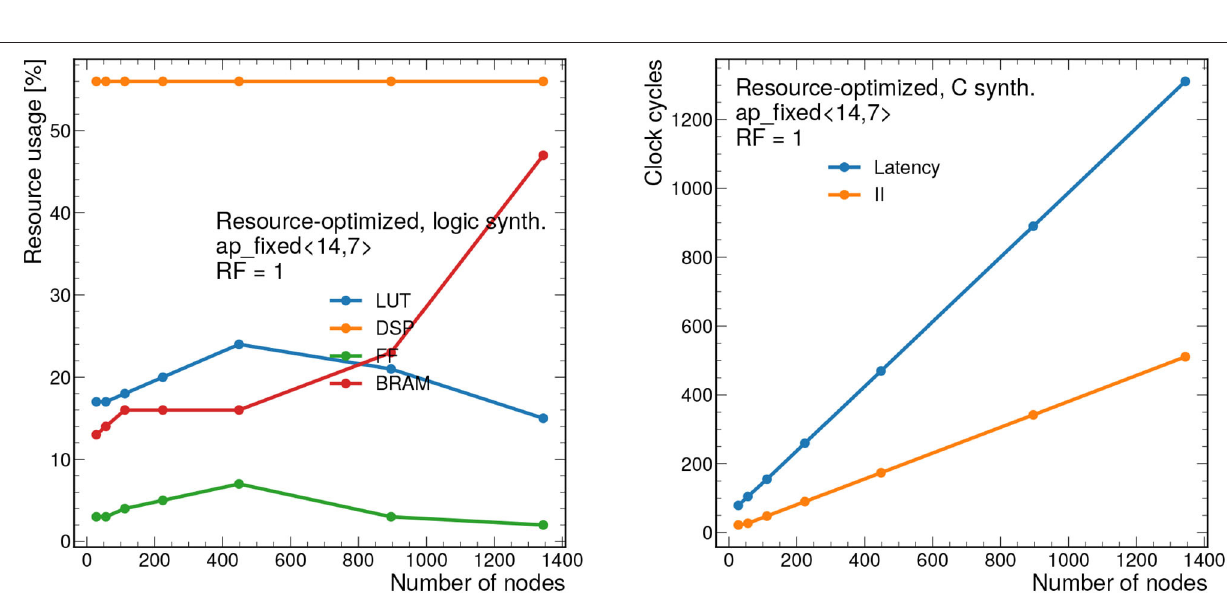
2 n nodes , as is empirically observed for the 2GeV =